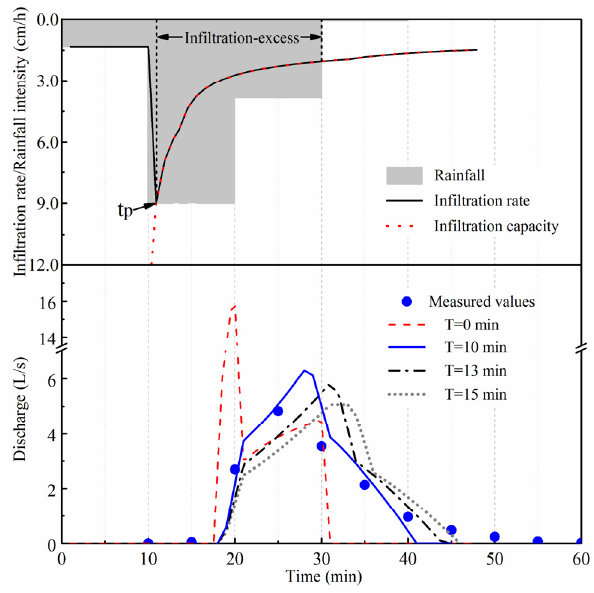
Figure 7. Simulated hydrographs of different concentration time in unified topography case in 20160808 rainfall event.